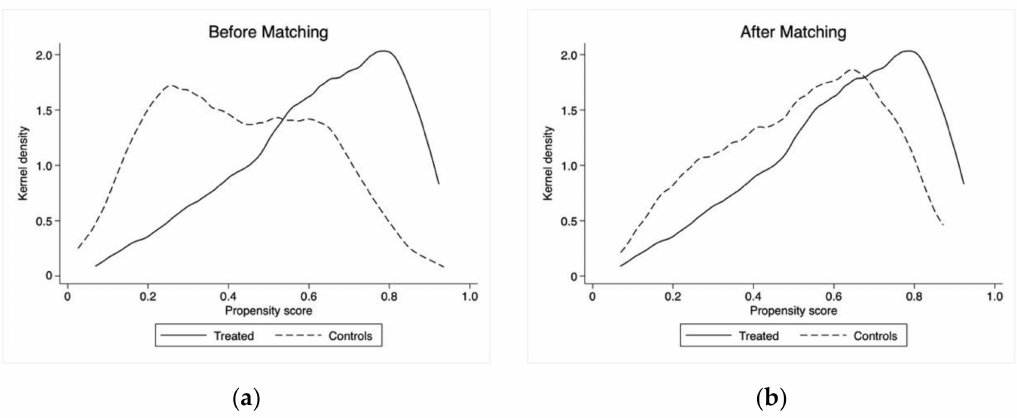
Figure 2. Propensity score distribution of rural credit participation before and after matching.